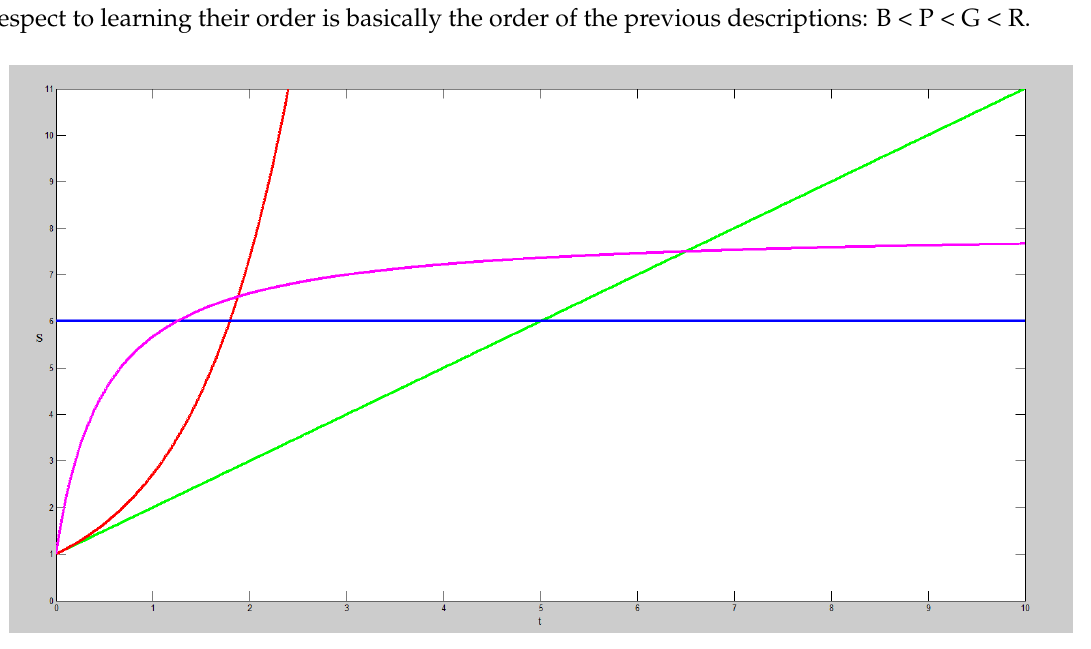
Figure 1. Four typical relations between time t and score S